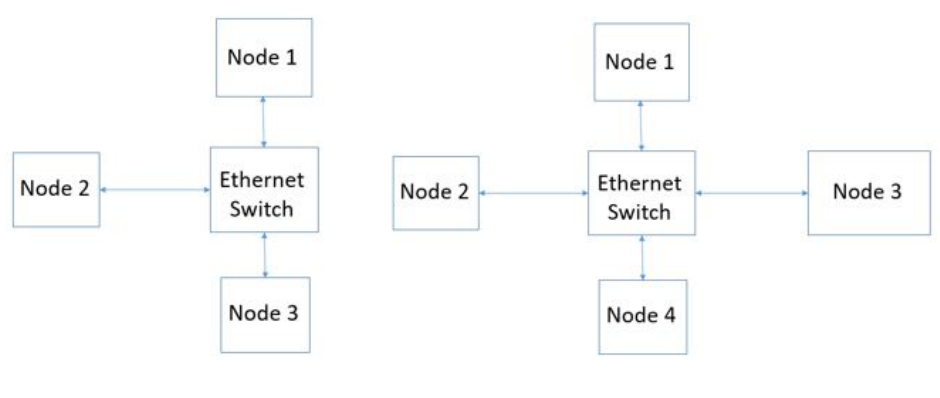
Figure 8. The logical Ethernet architecture for a three- and four-node setup.